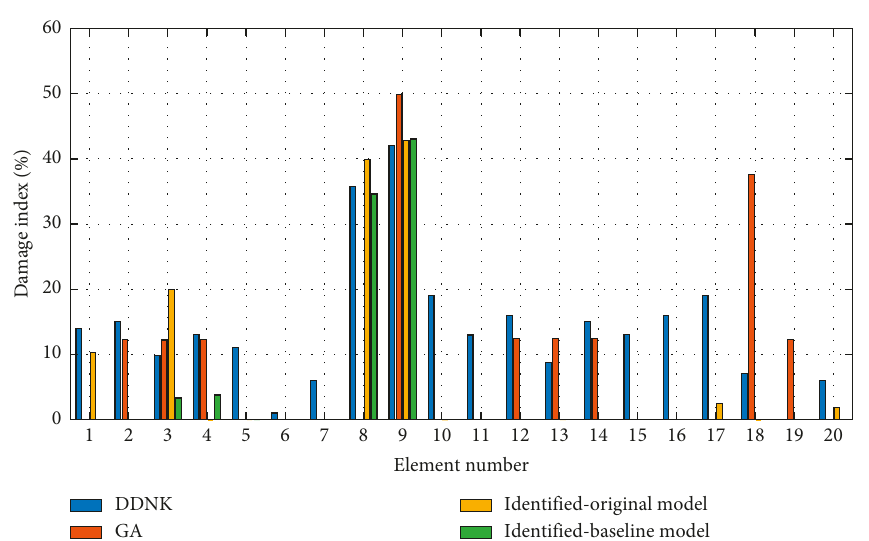
Figure 19: The identified parameters of the experimental